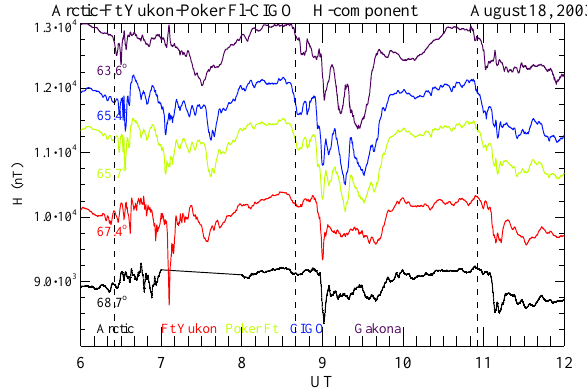
Fig. 12. Panels from top to bottom show H (horizontal) compo- nent traces from stations in Alaska (increasing latitude from top to bottom): Gakona (63.6 ◦ MLAT), CIGO (65.4 ◦ ), Poker Flat (65.4 ◦ ), Ft. Yukon (67.4 ◦ ), and Arctic Village (68.7 ◦ ) for the interval 06:00– 12:00UT. This interval corresponds to the 19:00–01:00MLT sector. Pseudo-breakups are marked by vertical dashed